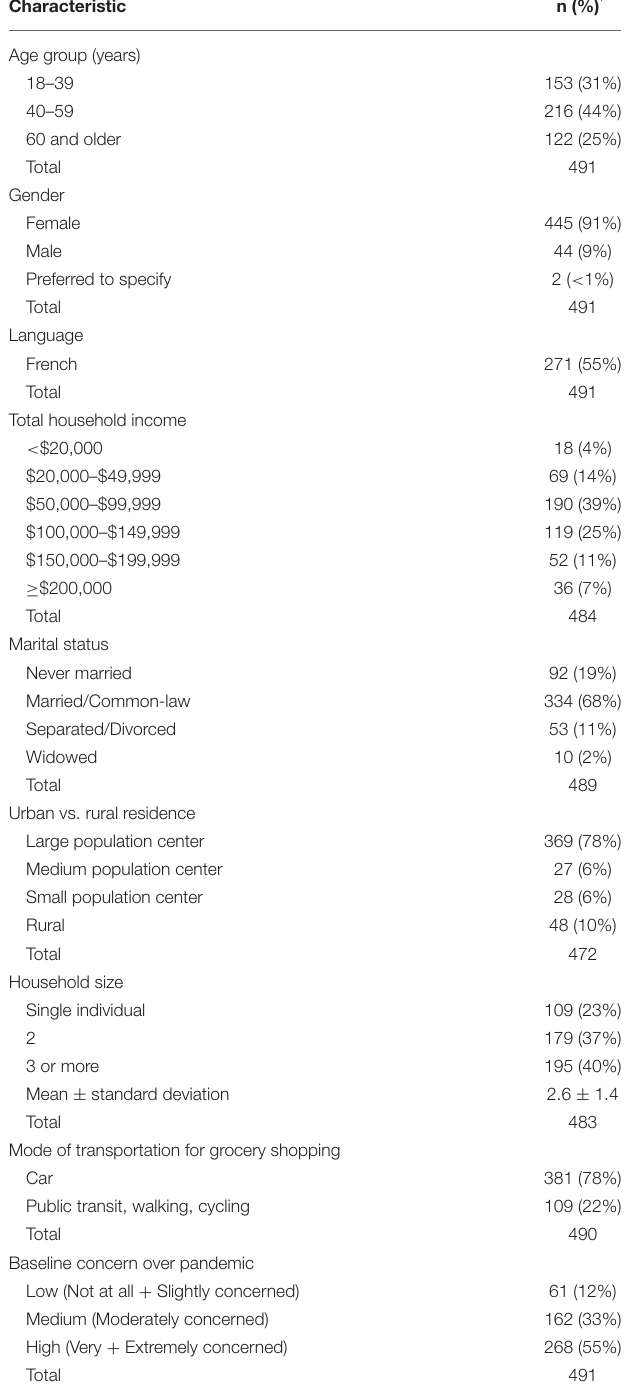
TABLE 1 | Baseline characteristics of